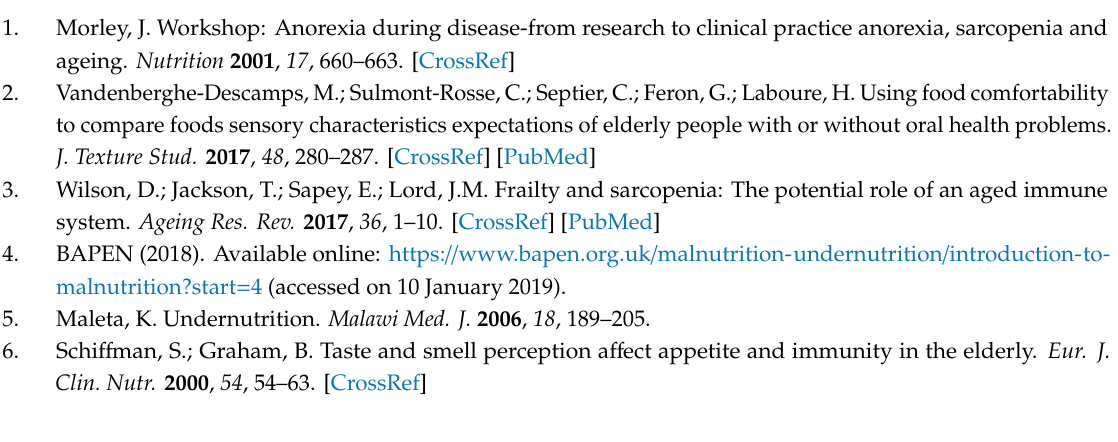
Figure S1. Additional factors influencing older adults salivary flow rates (mL / min) in both studies. Figure S2. Histogram of older adults unstimulated saliva flow data in both studies. Figure S3: Volunteers attribute perception mean ratings of cakes and biscuit by saliva flow (SF) (pilot study). Figure S4: Volunteers attribute perception mean ratings of cupcakes by saliva flow (SF) (main study). Table S1: Cake and biscuit (g per 100 g) ingredients formations in both studies. Table S2: Additional factors influencing volunteers liking, easiness to eat and swallow, attribute perception, appropriateness of attribute level (Just-About-Right) and appetite of product in both studies. Table S3: Volunteer counts of cake and biscuit preference in the pilot study. Table S4: Summary of volunteers comments in both